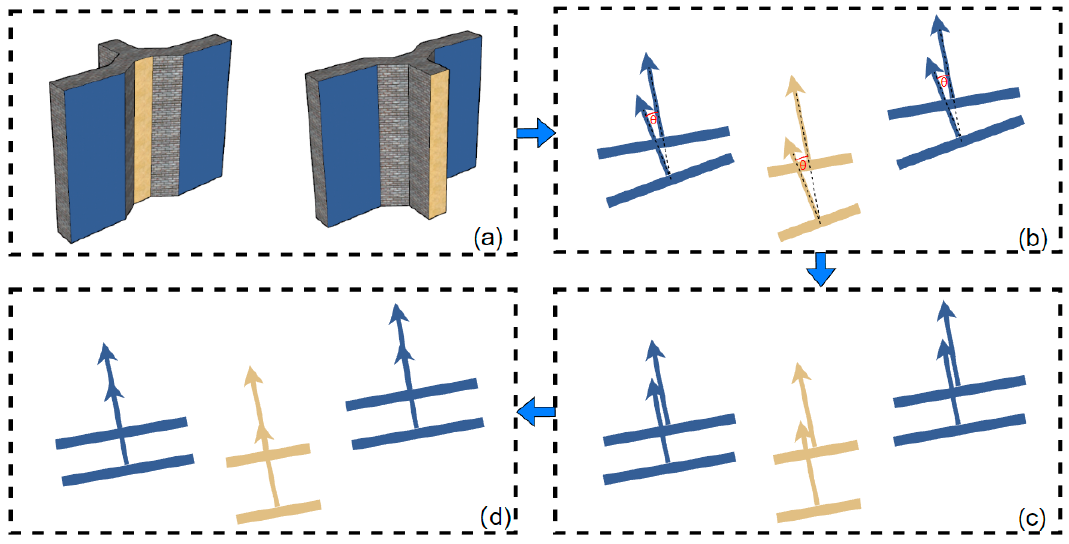
Figure 6. Schematic diagram of the spatially positioned fusion point cloud process using pairs of building elevations. ( a ) Ideal paired target and source facades with the same color facade spatial positions parallel. ( b ) The arrows indicate the corresponding normal vectors of the facades, and the normal vectors are not parallel with obvious pinch angles. ( c ) The normal vectors of the opposing elevations are parallel after rotation correction of the facade positions. ( d ) Exact translation correction of the facade position.